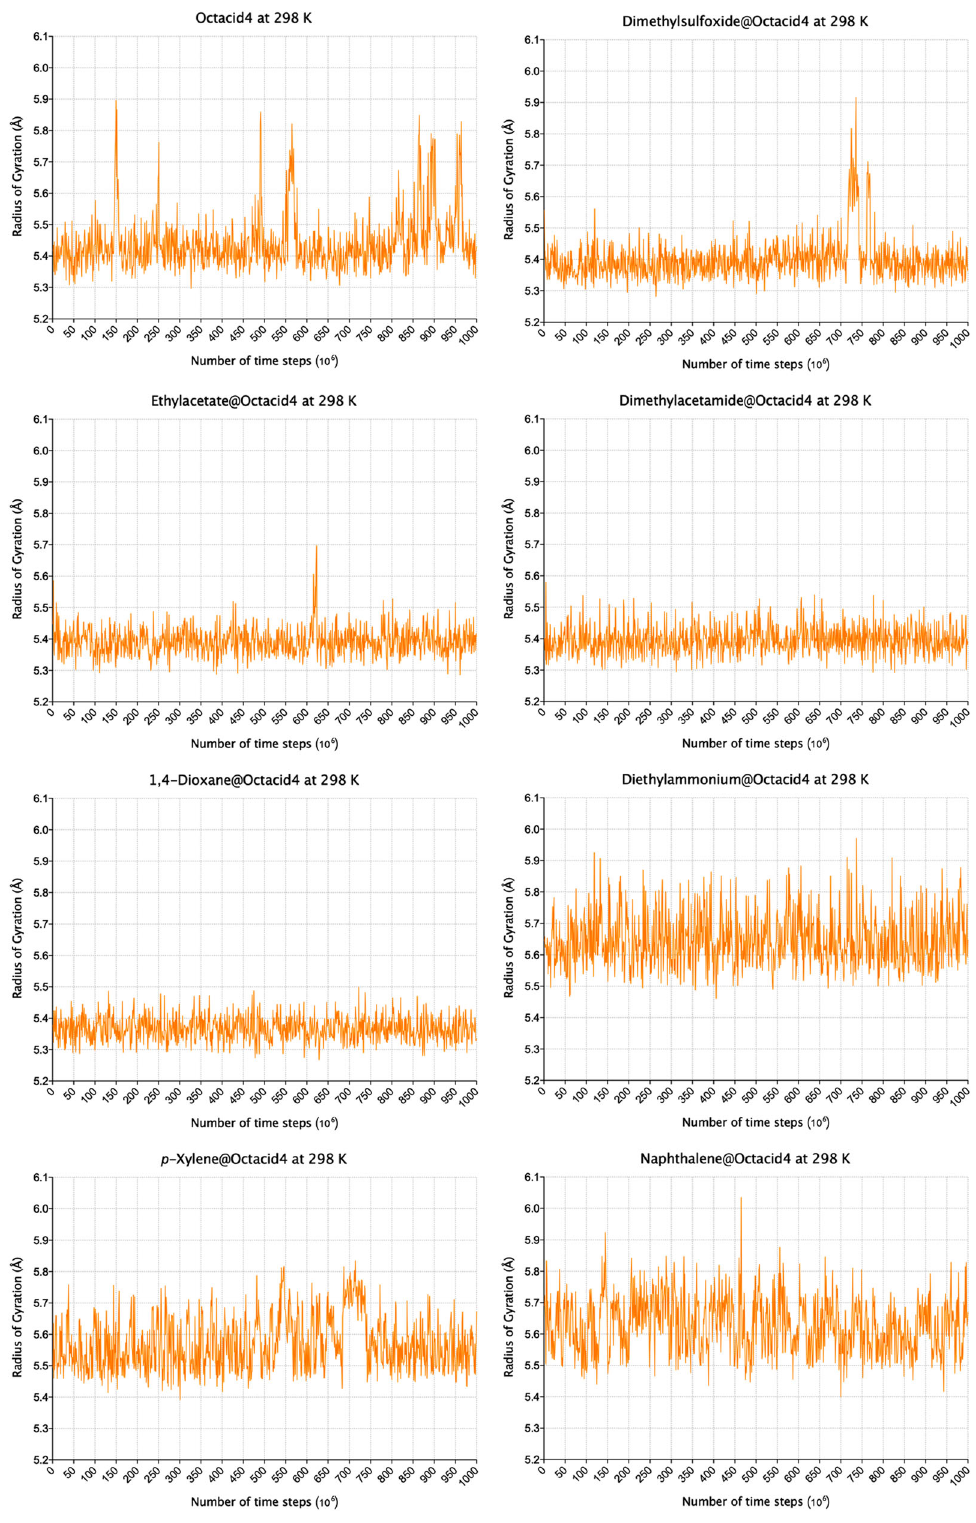
Fig. 5 Time series of radius of gyration of the Octacid4 cavity. Each time series was derived from the fi rst of 20 distinct and independent MD simulations at 298 K (see Fig. S1 for those from all 20 simulations at 298/340/363 overlapping carbon atoms on the other (Figs. 6b, S4b, and S5b), indicating that the guest had rotated around multiple axes.